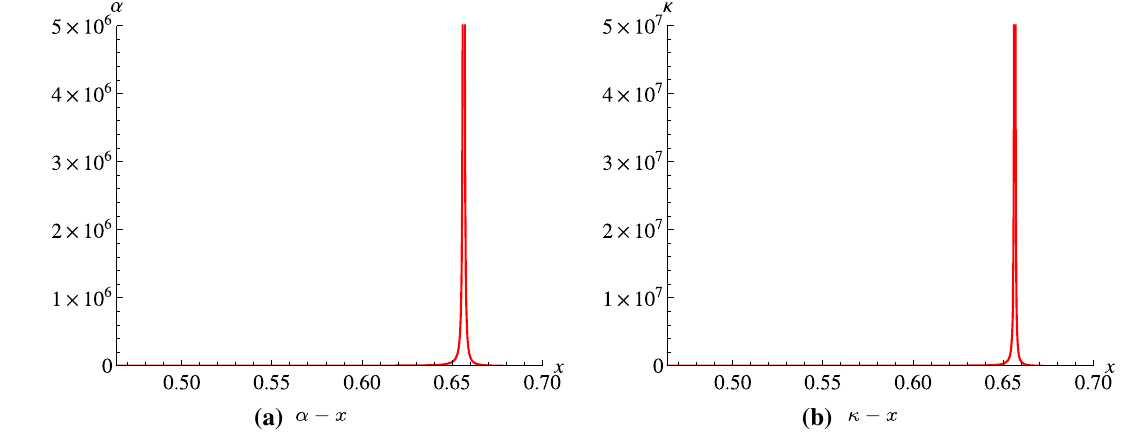
Fig. 6 The pictures of three coefficients with two horizons’ radio x nearby the critical point